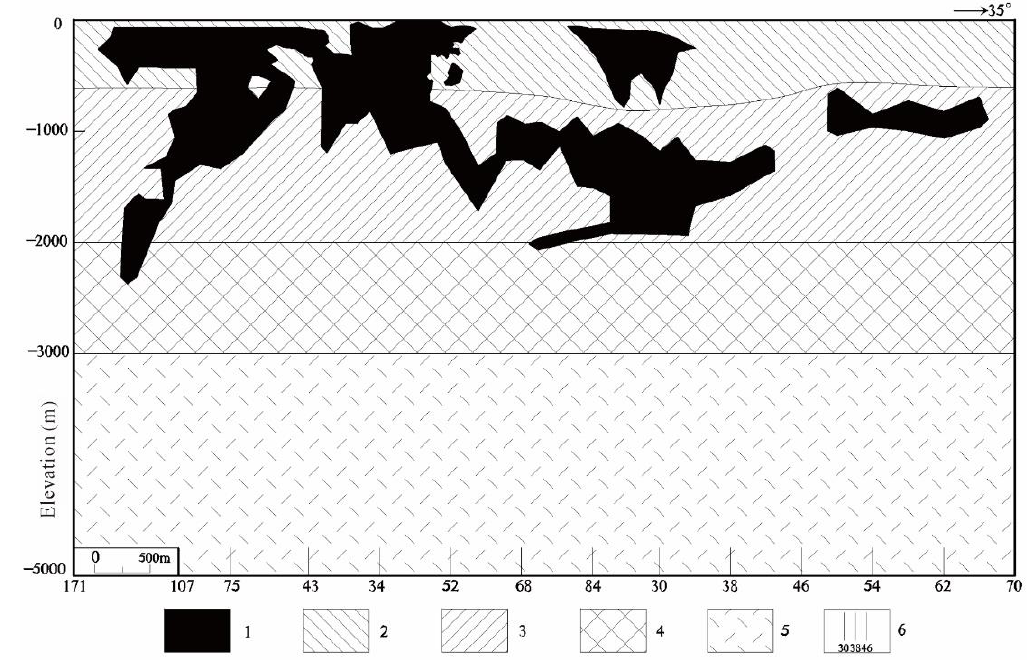
Figure 12. Vertical longitudinal projection map for the deep resource prediction of the Sanshandao fault. 1—Range of controlled gold orebodies; 2—Scope for the calculation of the shallow ore-bearing rate; 3—Scope for the calculation of the deep ore-bearing rate; 4—Prediction range at an elevation of − 3000– − 2000 m; 5—Prediction range at an elevation range of − 5000– − 3000 m; 6—Exploration lines and their numbers. Table 6. Ore-hosting rates of the Sanshandao fault.